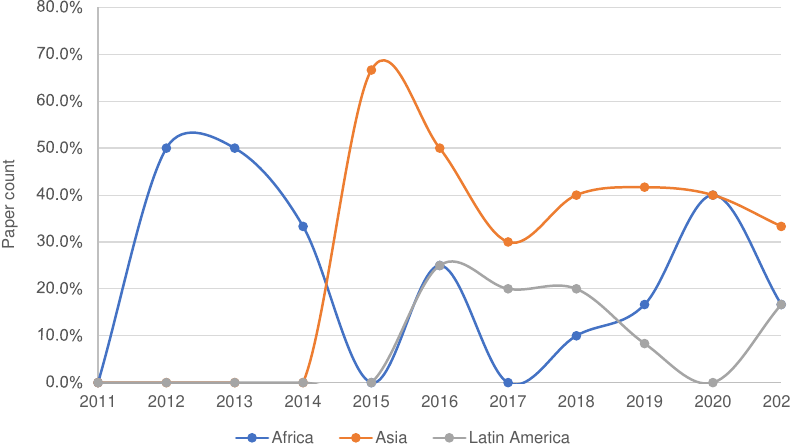
Figure 12. Temporal distribution of IoT and WSN applications in smallholder agriculture. The Y-axis values indicate percentage distribution of works targeting each continent in the specified time